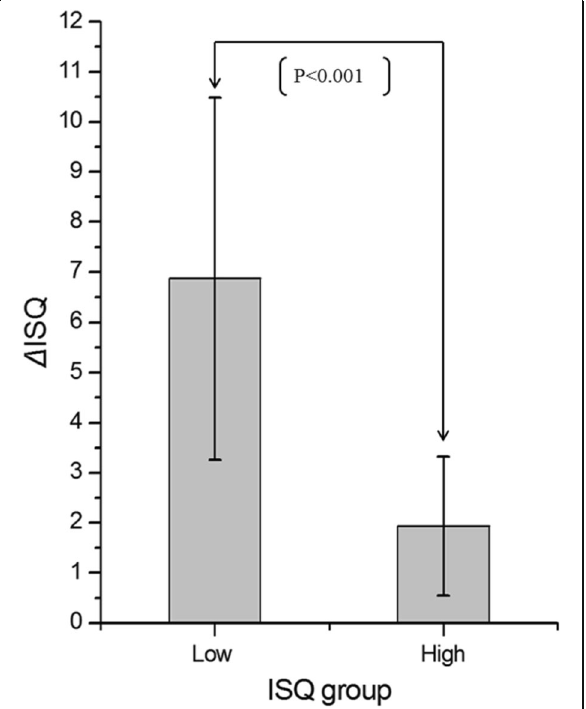
Fig. 4 The mean increase of implant stability quotient (ISQ) after bone graft procedure in both the low and the high primary stability groups